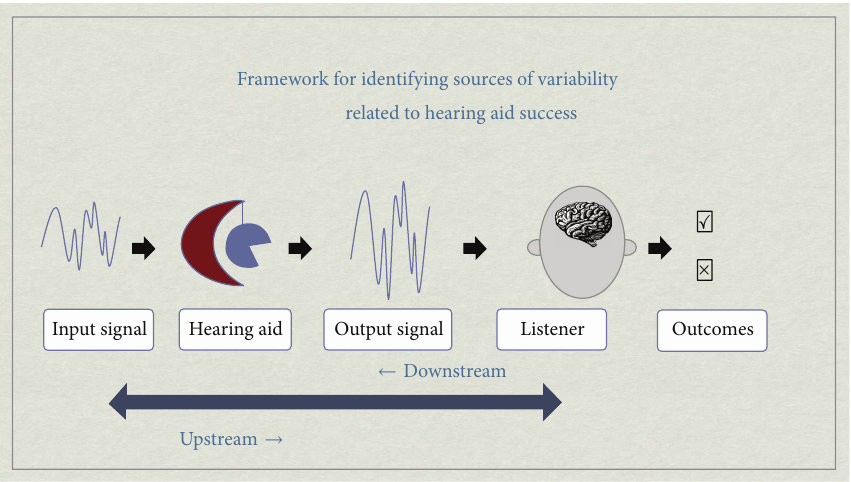
Figure 1: Framework for identifying sources of variability related to hearing aid